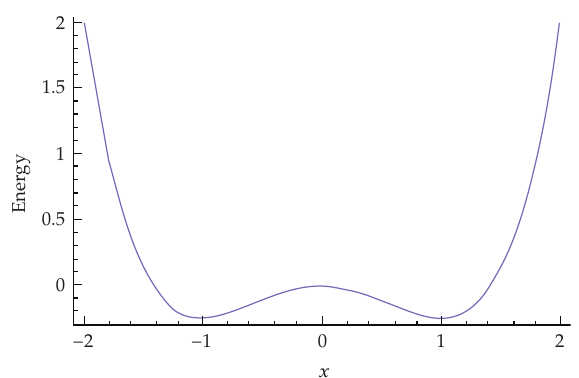
Figure 2: Energy landscape of a 1-dimensional system with r (cid:8) 1.